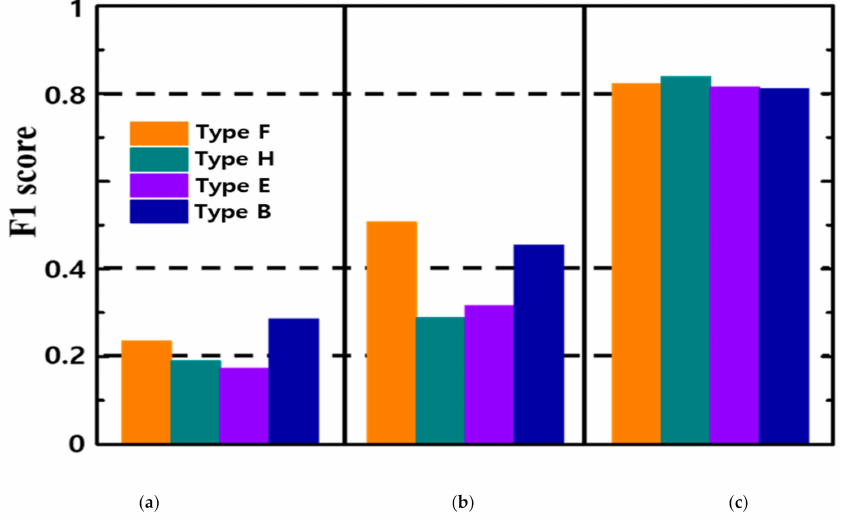
Figure 9. Evaluation result of four images (F1 score): ( a ) Image without pre-processing; ( b ) Image with pre-processing before learning; ( c ) Image with pre-processing after